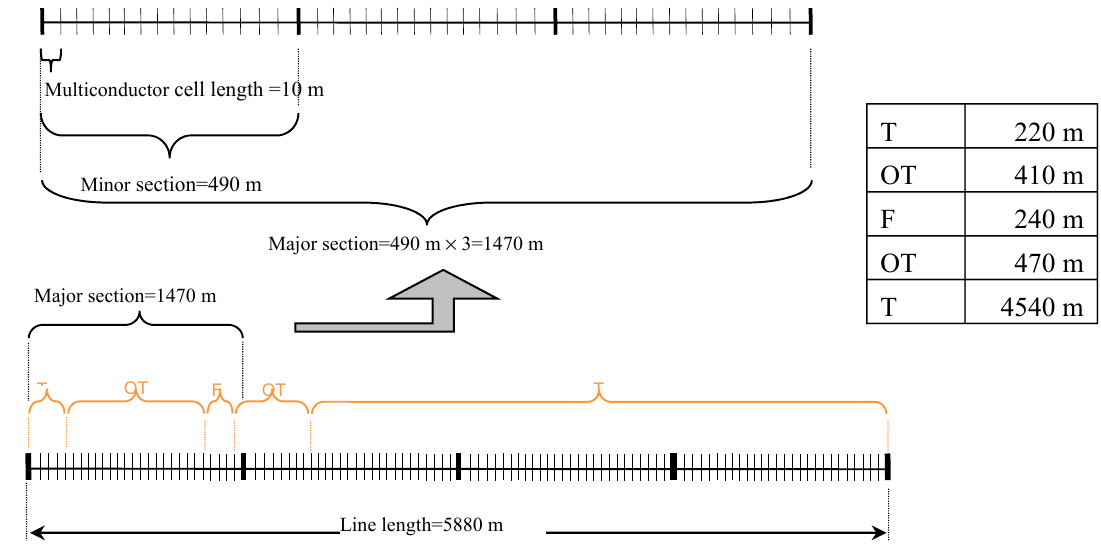
Figure 8. Subdivision of case #2 in elementary cells, minor and major sections. OT—open trefoil with spacing = 0.225 m; F—flat laying with spacing = 0.35 m; T—close trefoil.